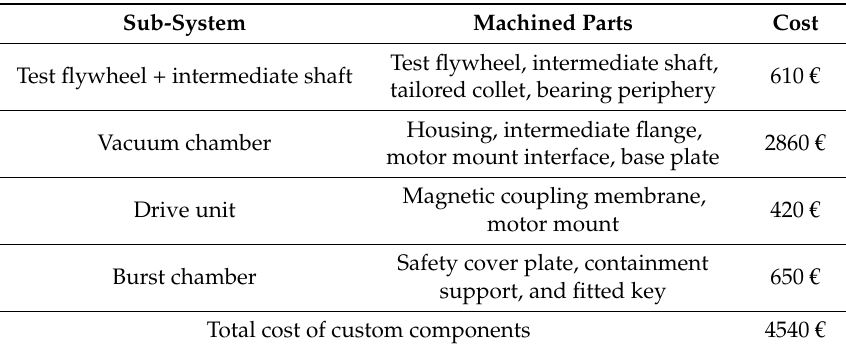
Table 4. Custom components used in the test rig.